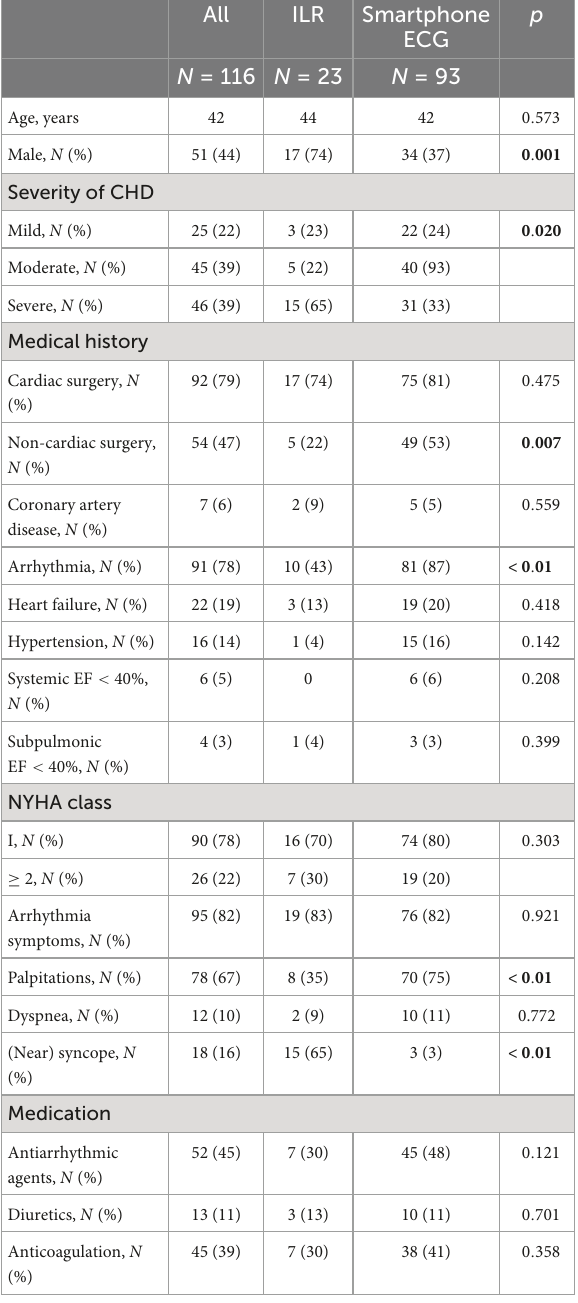
TABLE 1 Baseline